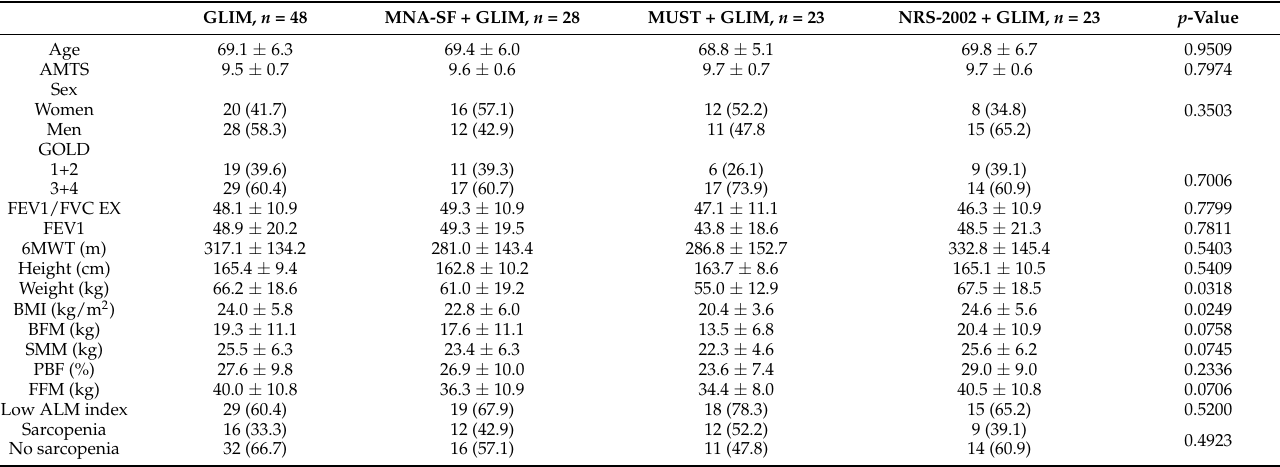
Table 2. Anthropometric characteristics and clinical data of subjects with malnutrition diagnosed based on four different diagnostic